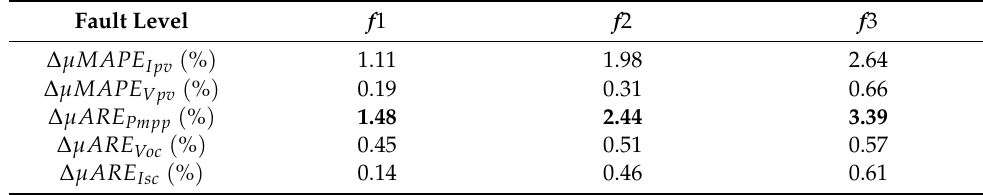
Table 19. Fault effect on the I–V curve characteristics.